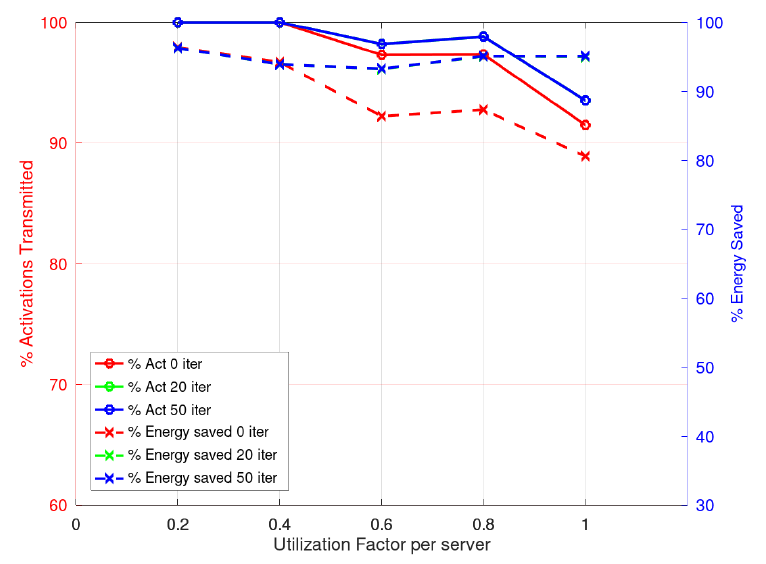
Figure 5. Maximizing activation